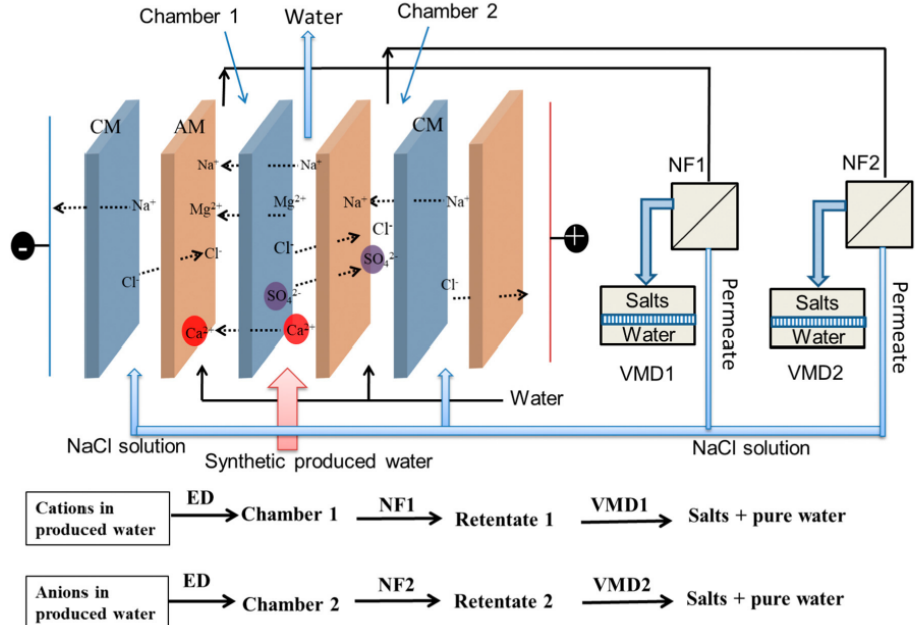
Figure 2. Diagram of the integrated ED-NF-MD system. CM: cation exchange membrane; AM: anion exchange membrane; ED: electrodialysis; NF: nanofiltration; VMD: vacuum membrane distillation. Reproduced with permission from Zhao et al., 2020